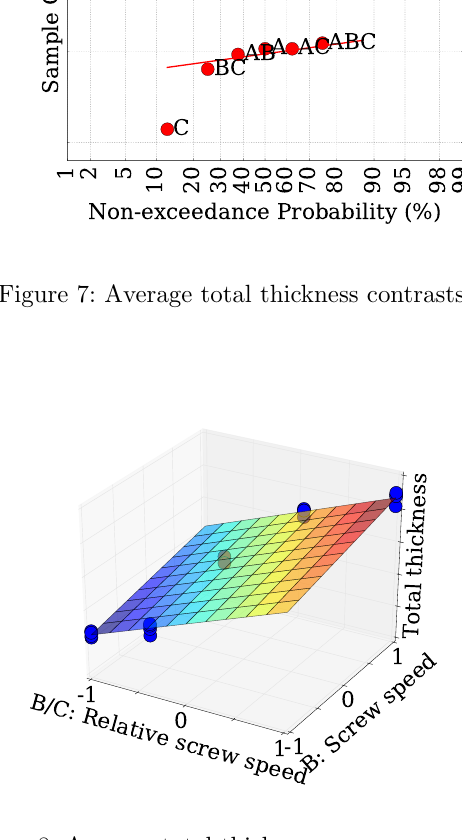
Figure 8: Average total thickness response